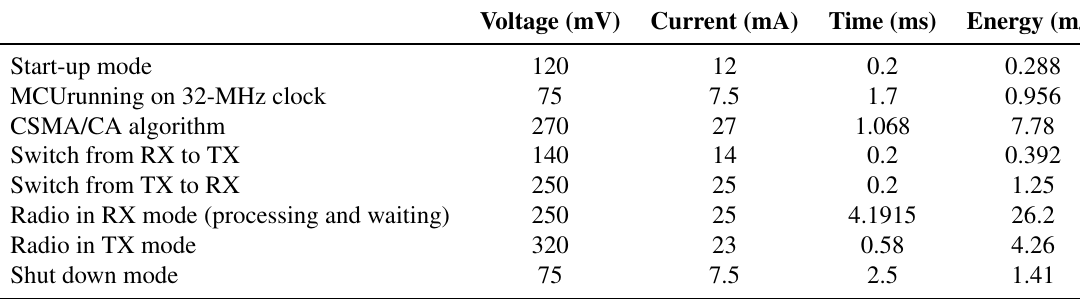
Table 8. Energy model [17].